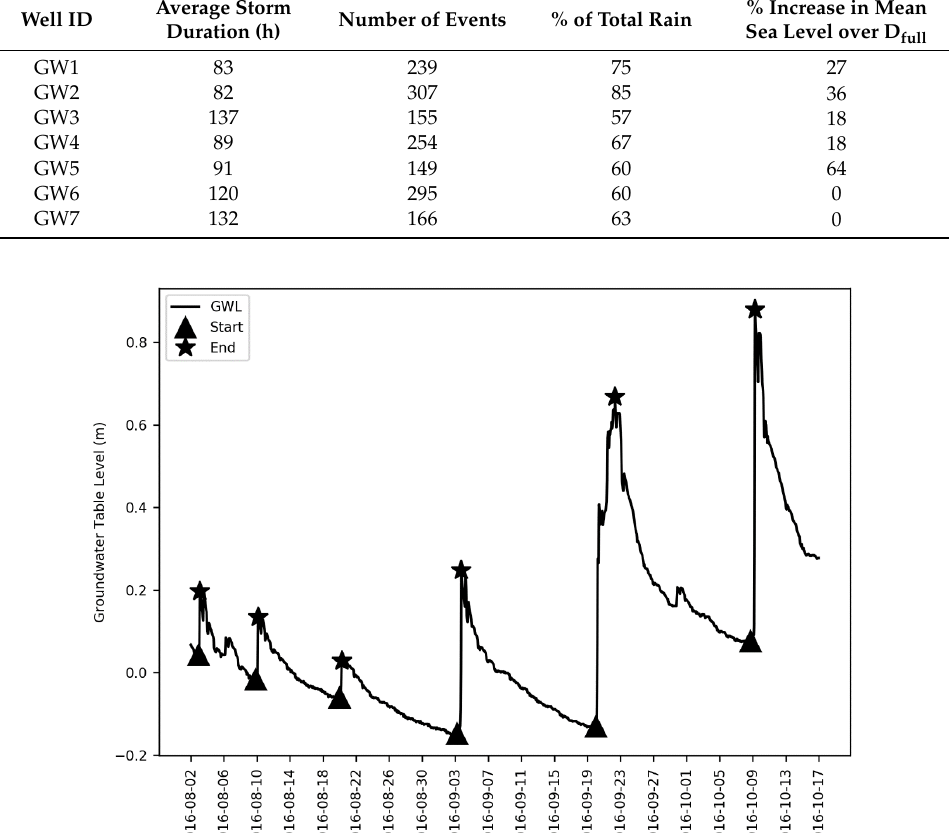
40 Table 9. Tuned hyperparameters for LSTM models. Well